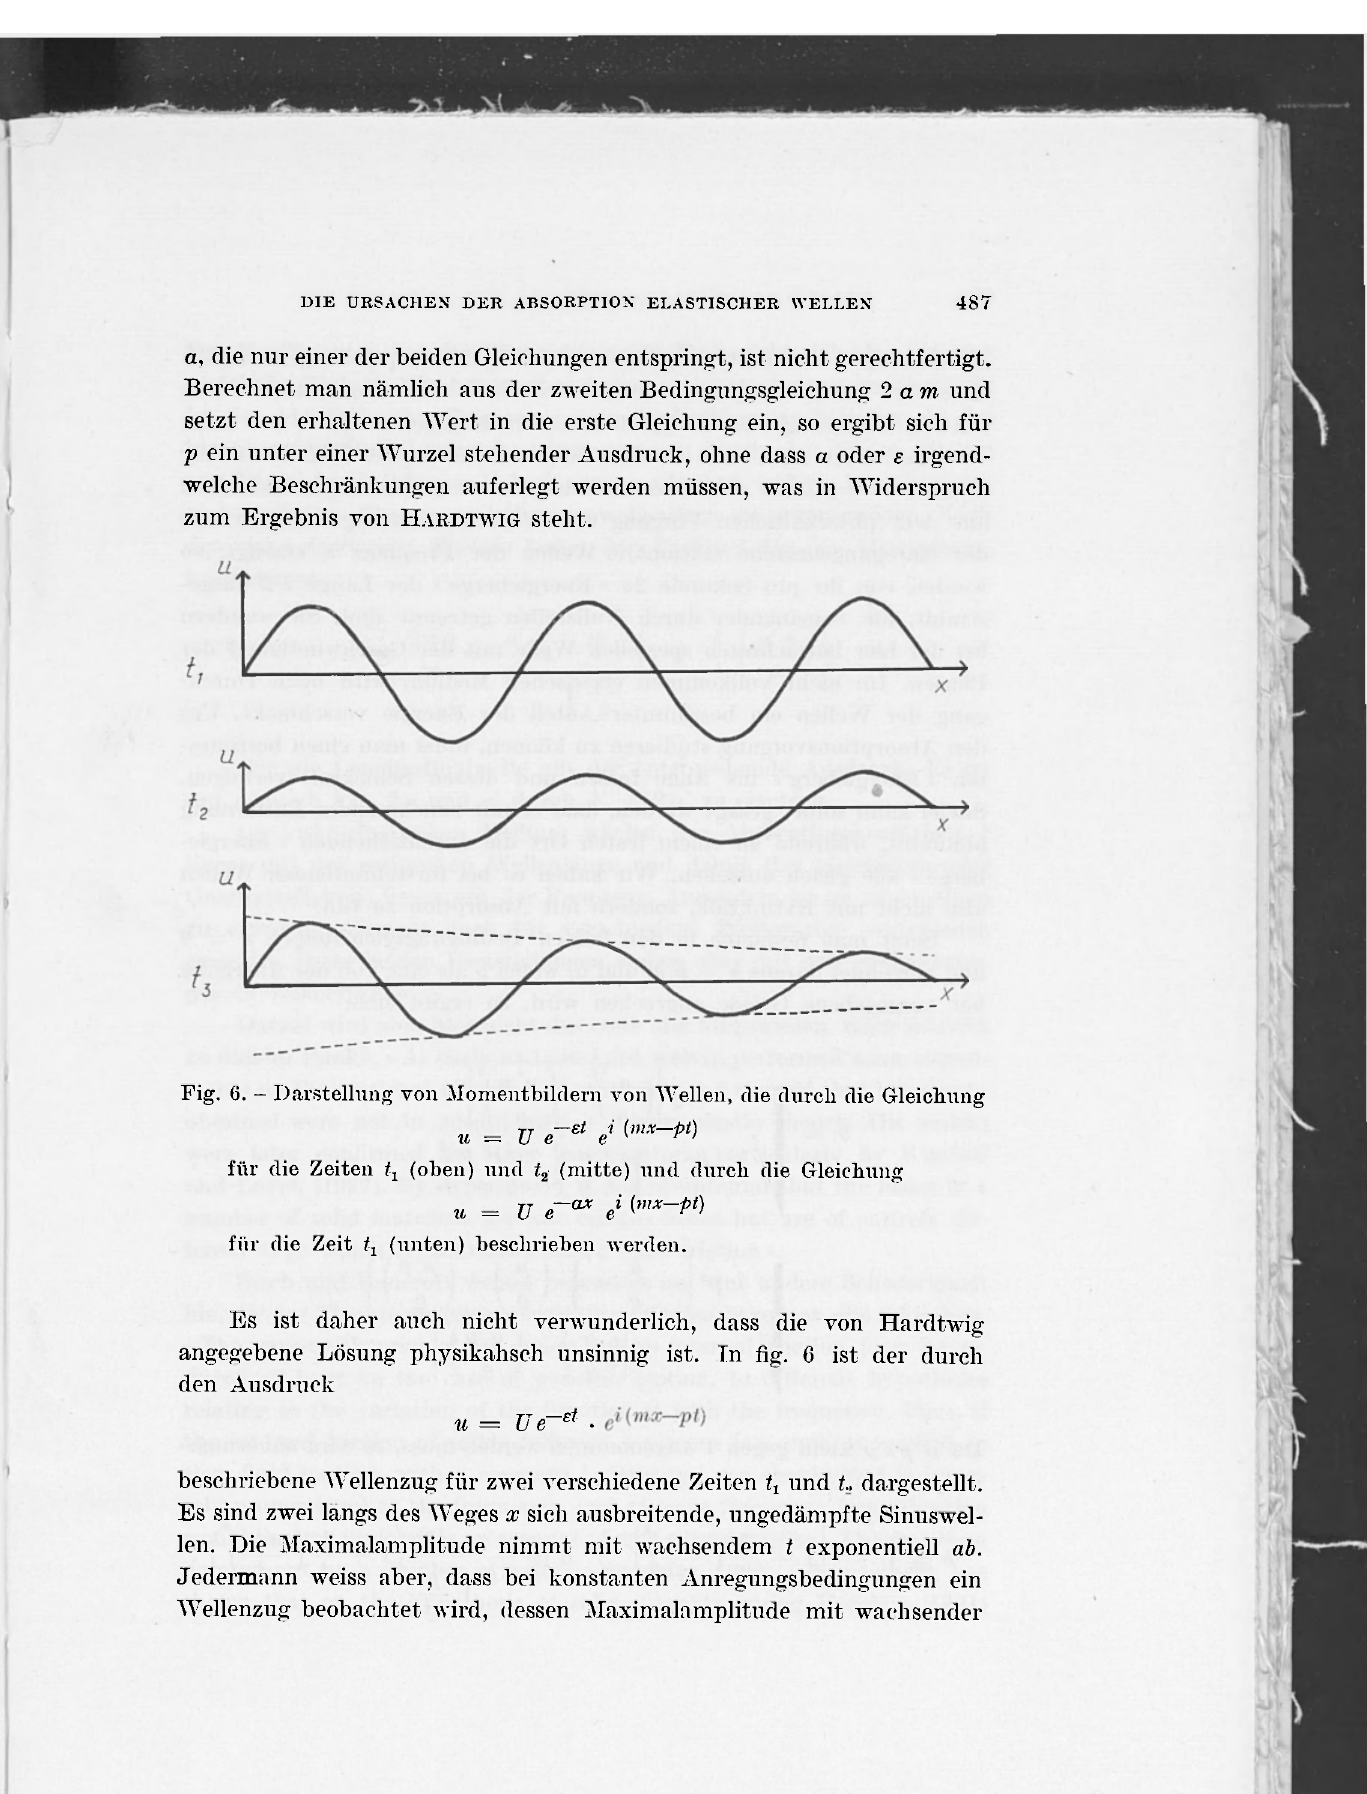
Fig. 6. - Darstellung von Momentbildern von Wellen, die dureli die Gleichung u = TJ e~ Et j {mx ~ pt ) fiir die Zeiten t x (oben) und / 2 (mitte) und durch die Gleichung u = V e-** e 1 ^-Pt) fiir die Zeit t x (unten) beschrieben